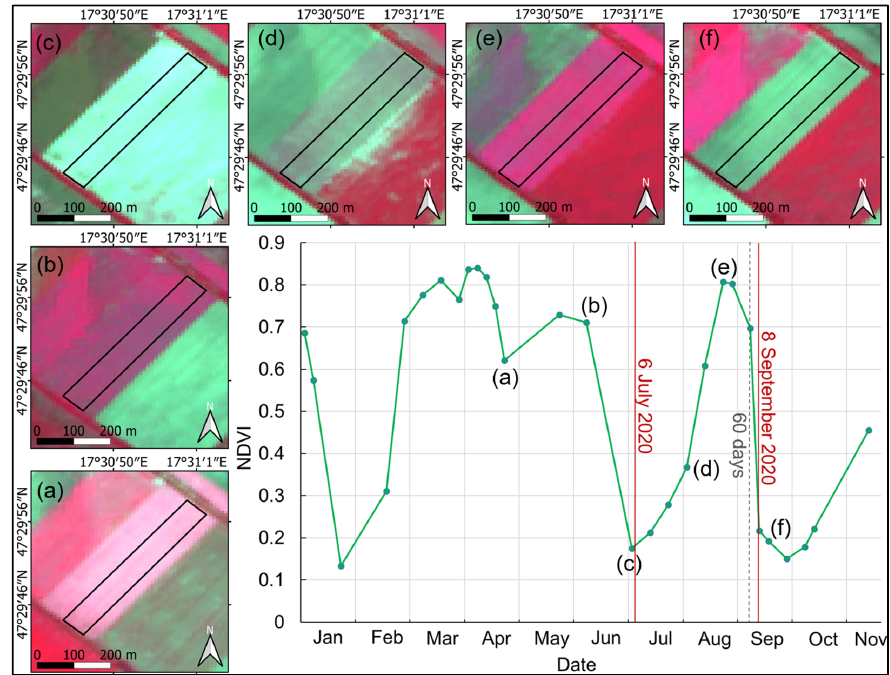
Figure 9. Example of detected catch crop with start and end date on an NDVI time series and subsets